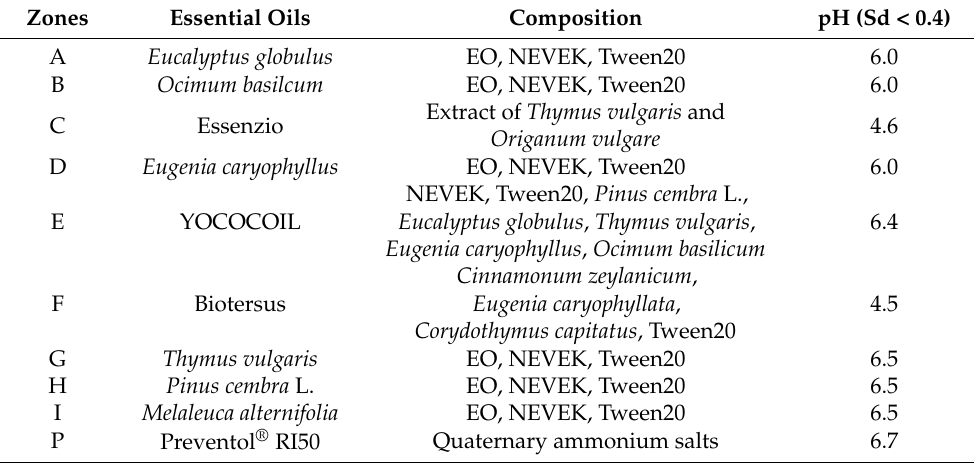
Table 1. Reagents used in the experimentation and zones of application.